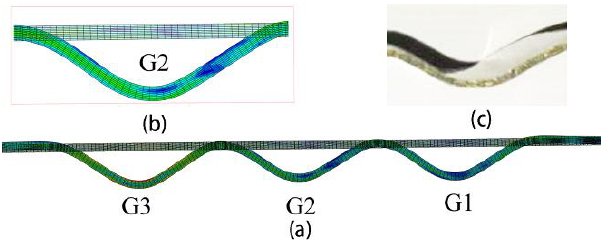
Figure 5. Final groove shapes. ( a ) Final result and origin blank; ( b ) enlarged view of G2; ( c ) groove section of experimental result.